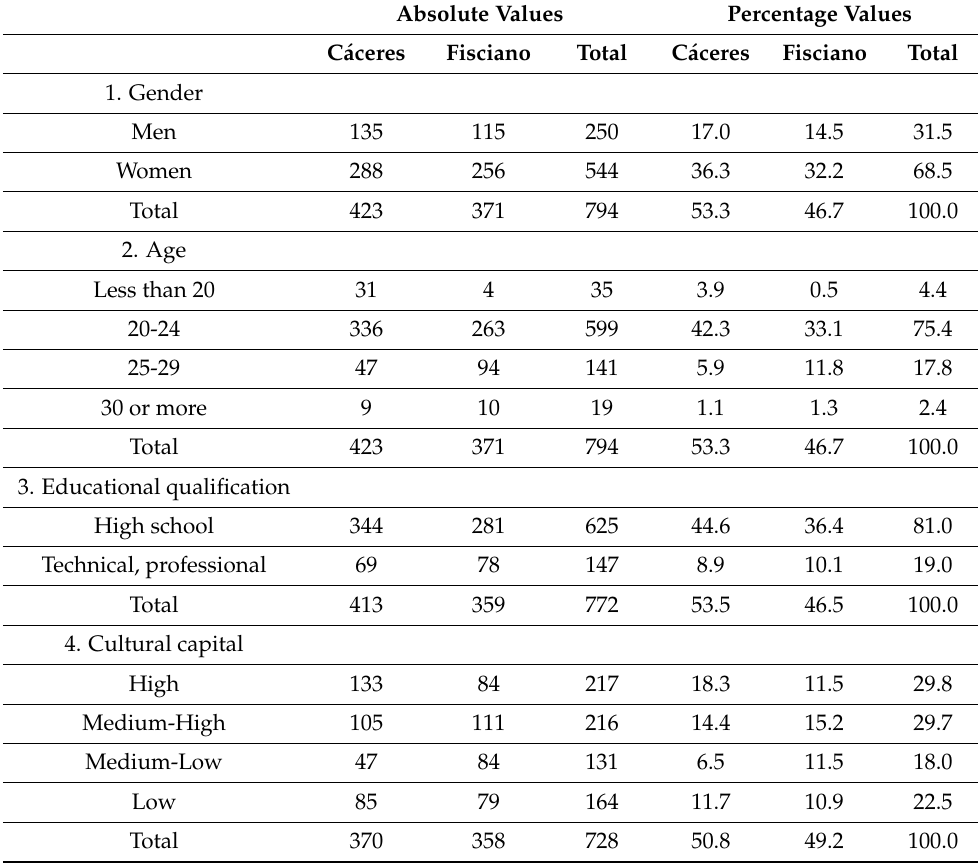
Table 1. Main sample